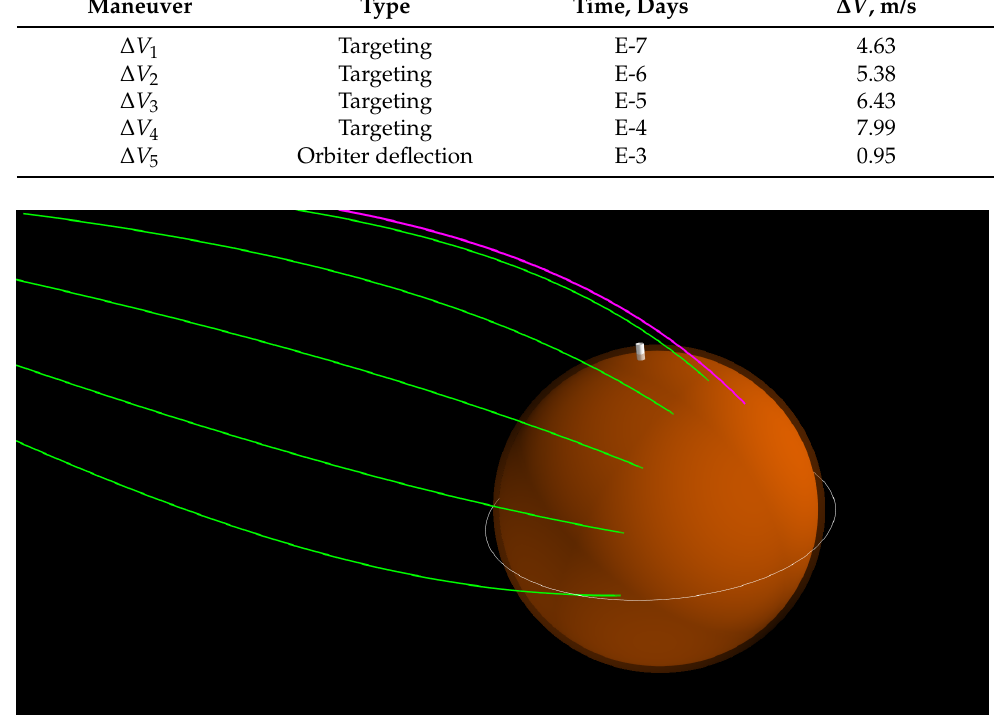
Figure 27. Approach trajectory of the five Mars small satellites with various inclinations (green) until atmospheric entry and the host orbiter (magenta) until